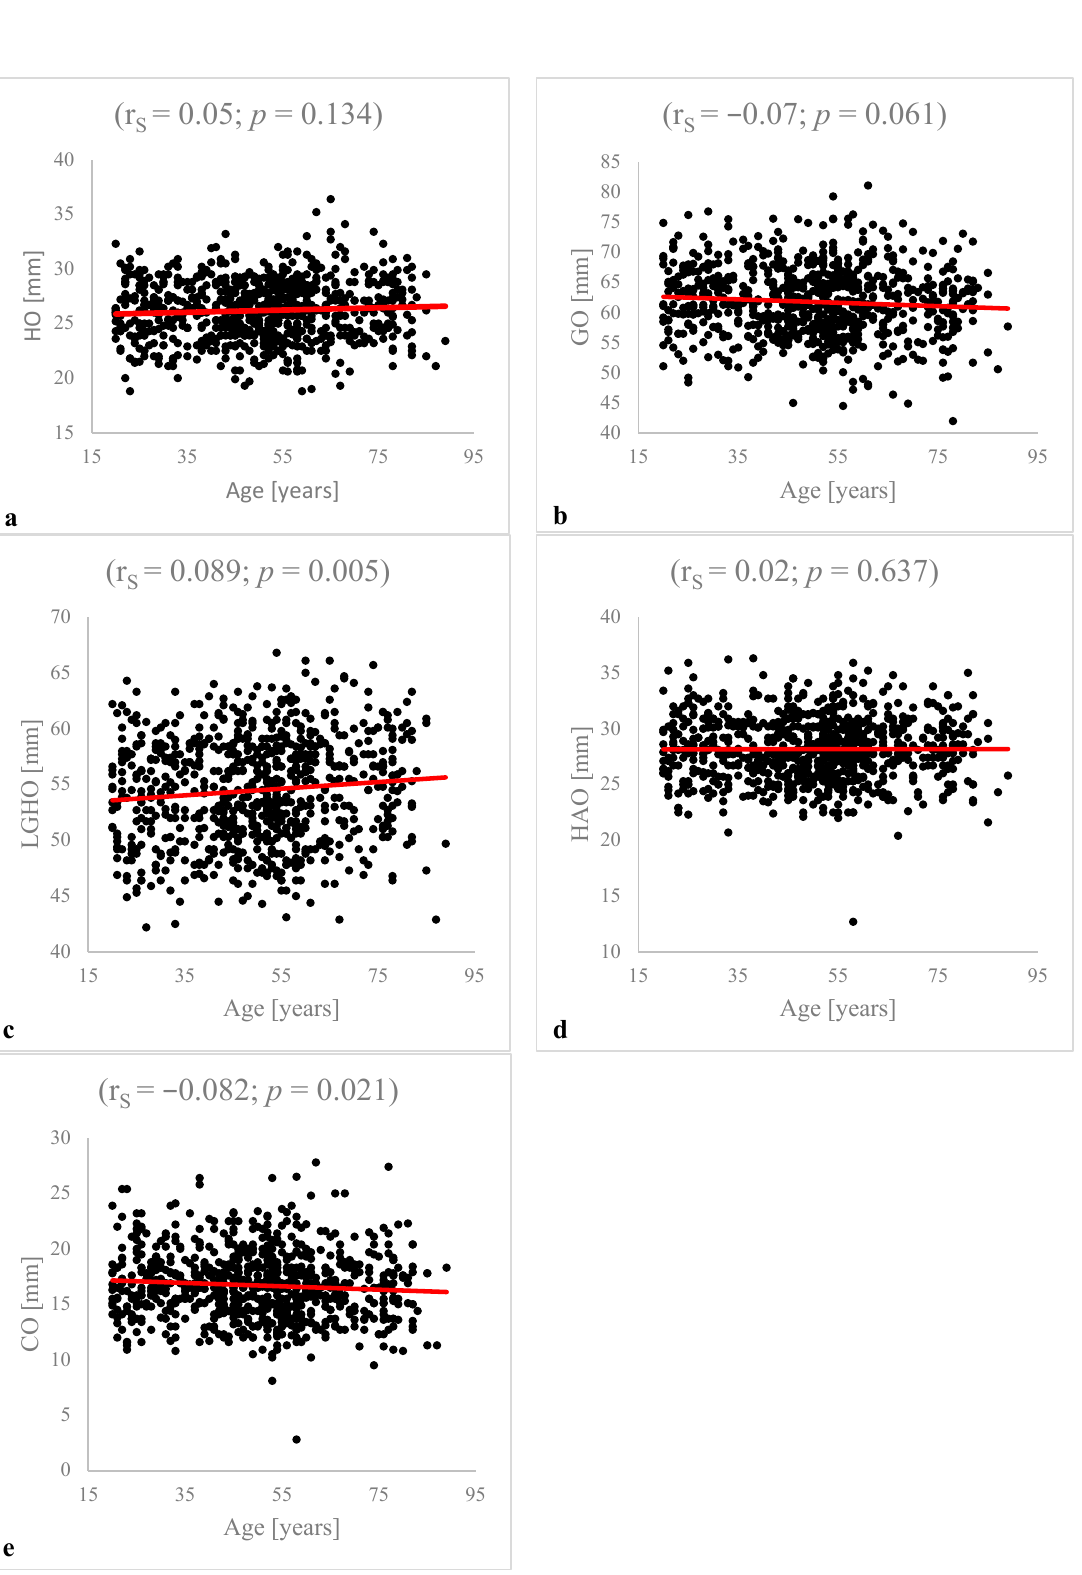
Figure 2. Correlation analysis between patients’ age and HO, GO, LGHO, HAO and CO: The analysis is based on Spearman correlations. There was no significant correlation between patient age and HO (r S = 0.05; p = 0.134) ( a ), GO (r S = − 0.07; p = 0.061) ( b ) or HAO (r S = 0.02; p = 0.637) ( d ). The analysis detected a significant correlation between LGHO (r S = 0.089: p = 0.005) ( c ) and CO (r S = − 0.082; p = 0.021) ( e ) and patient